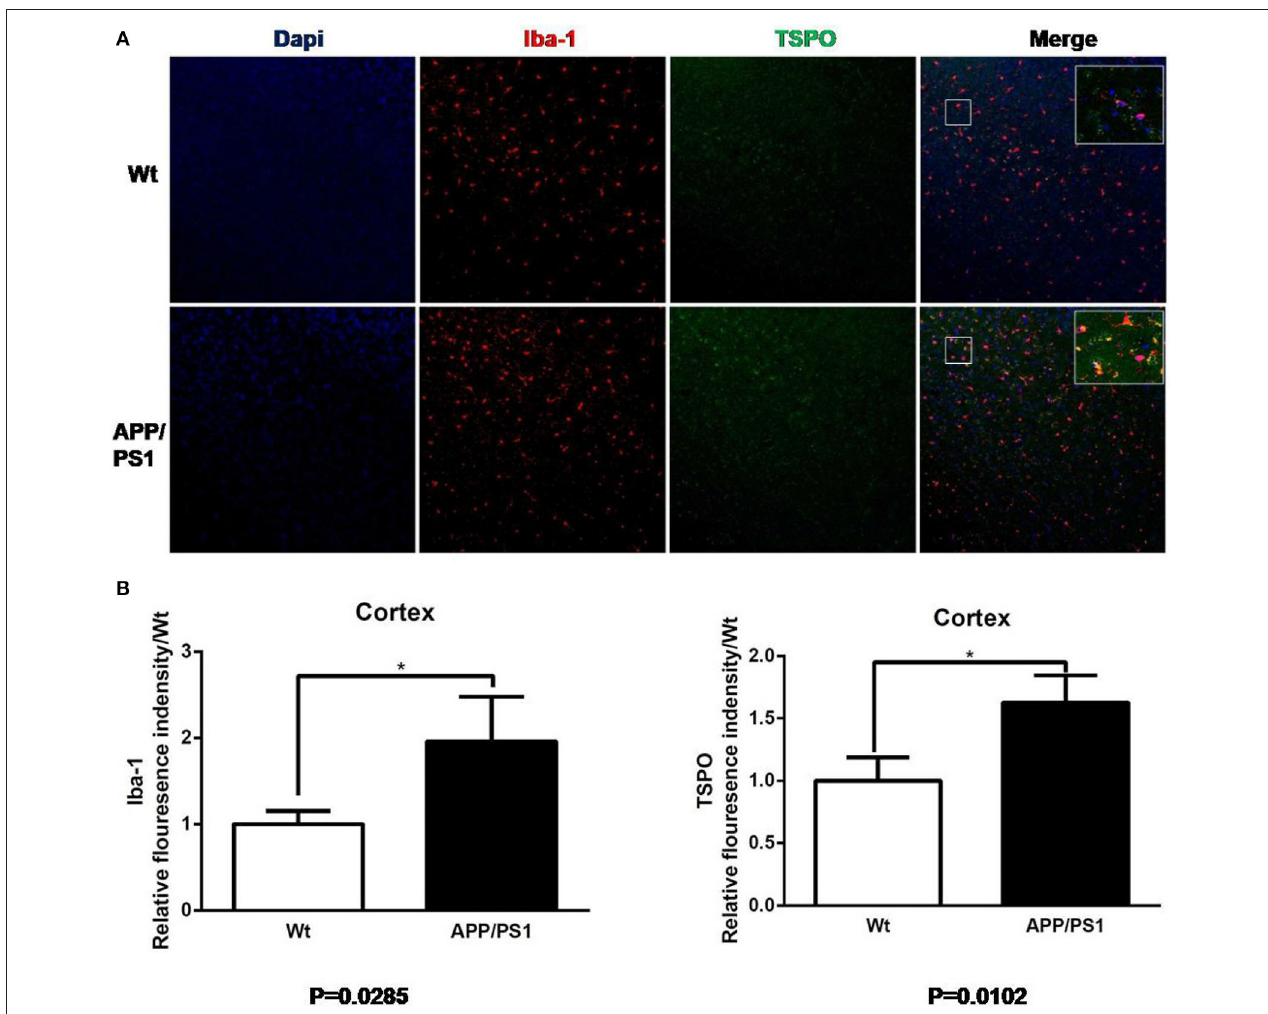
FIGURE 7 | Iba-1 and TSPO staining in cortex. (A) Representative images from 15- to 16-months-old APP/PS1 and Wt mice, Scale bar = 50 um, magnification, × 20. (B) Quantitation of TSPO and Iba-1 relative fluorescence intensity in the cortex of APP/PS1 mice relative to Wt mice. * p <